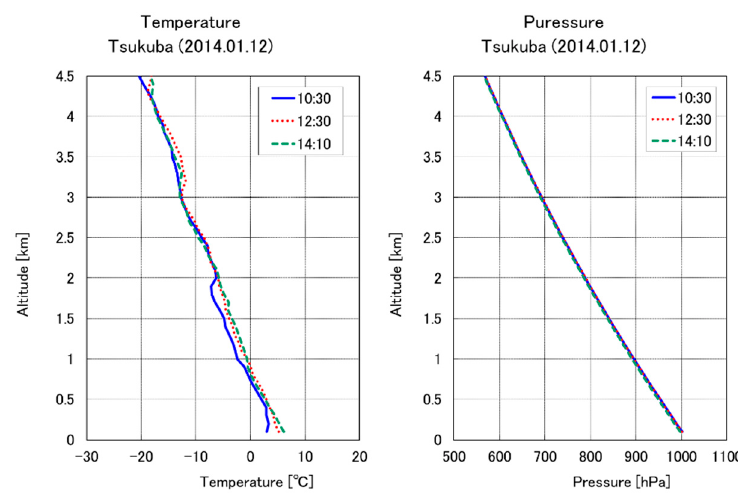
Figure 4. GPS sonde temperature ( left ) and pressure ( right ) profiles launched from Tsukuba on 12 January, 2014.